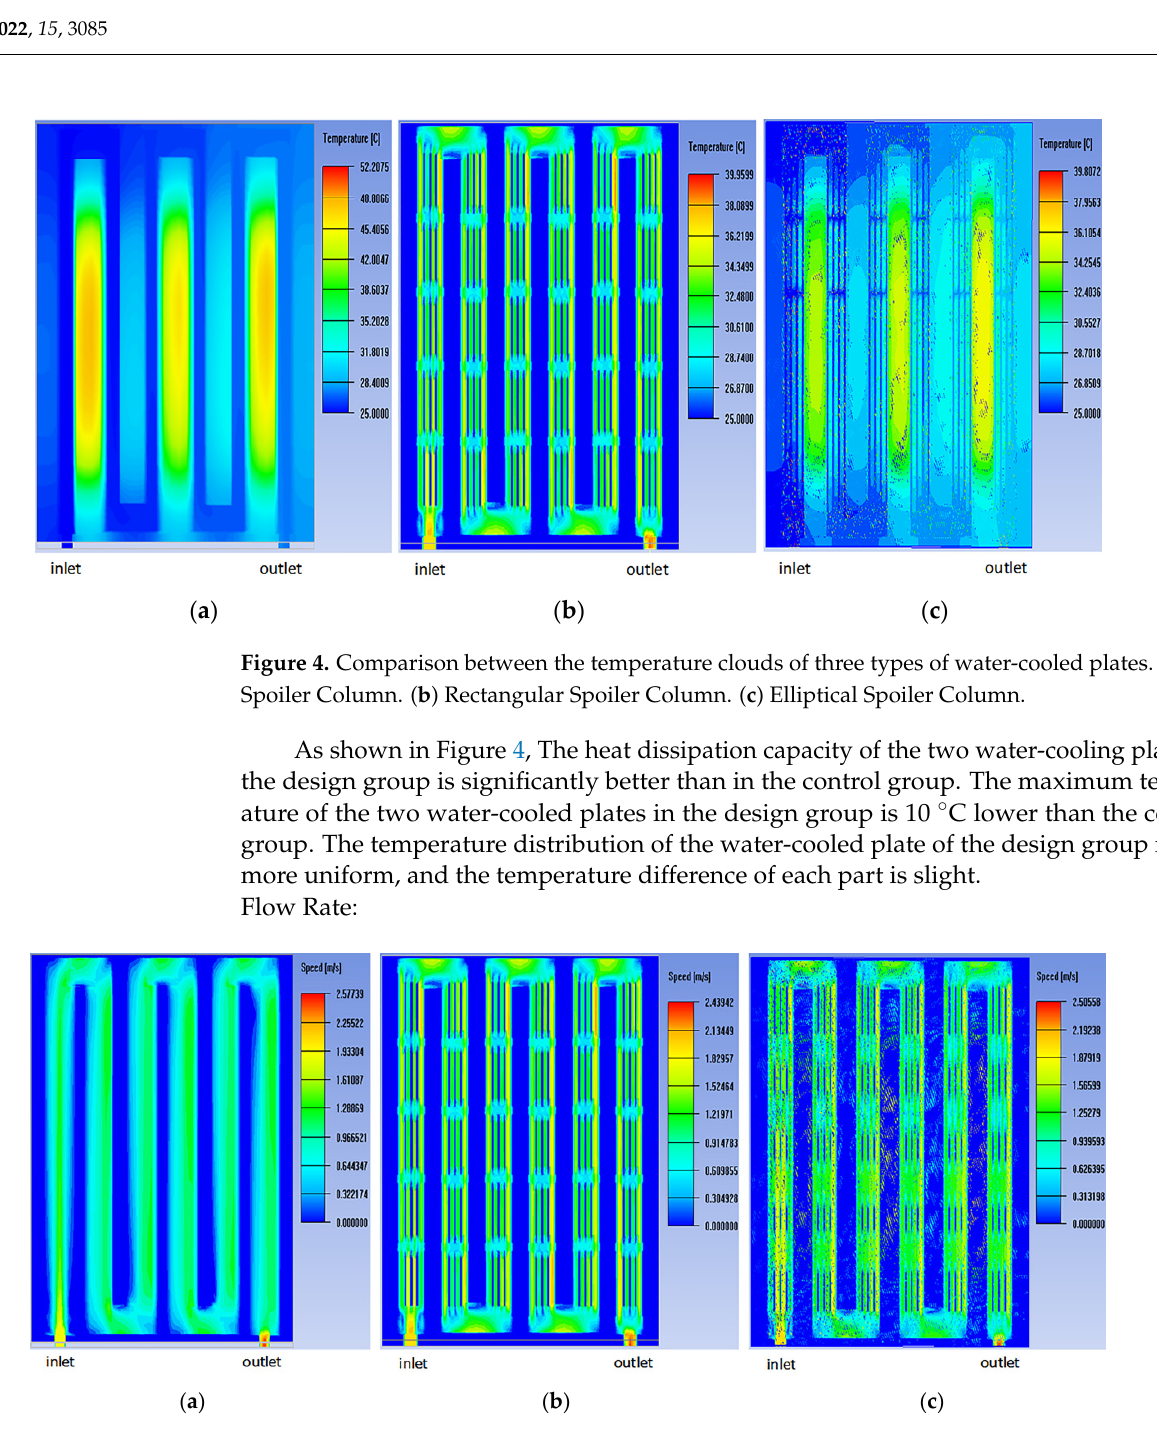
Figure 5. Comparison between the flow velocity clouds of three types of water ‐ cooled plates. ( a ) No Spoiler Column. ( b ) Rectangular Spoiler Column. ( c ) Elliptical Spoiler Column.